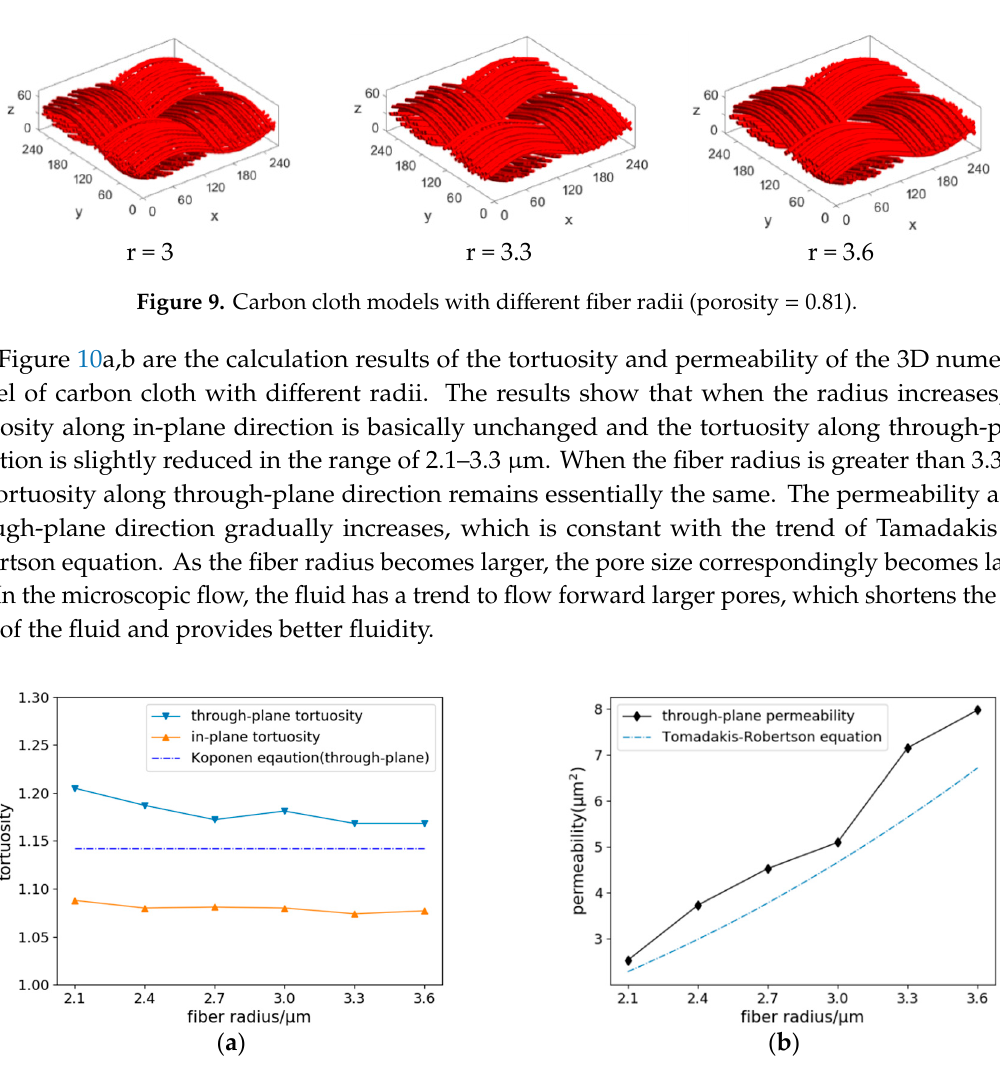
Figure 10. Calculated ( a ) tortuosity and ( b ) permeability of models with different fiber radii.